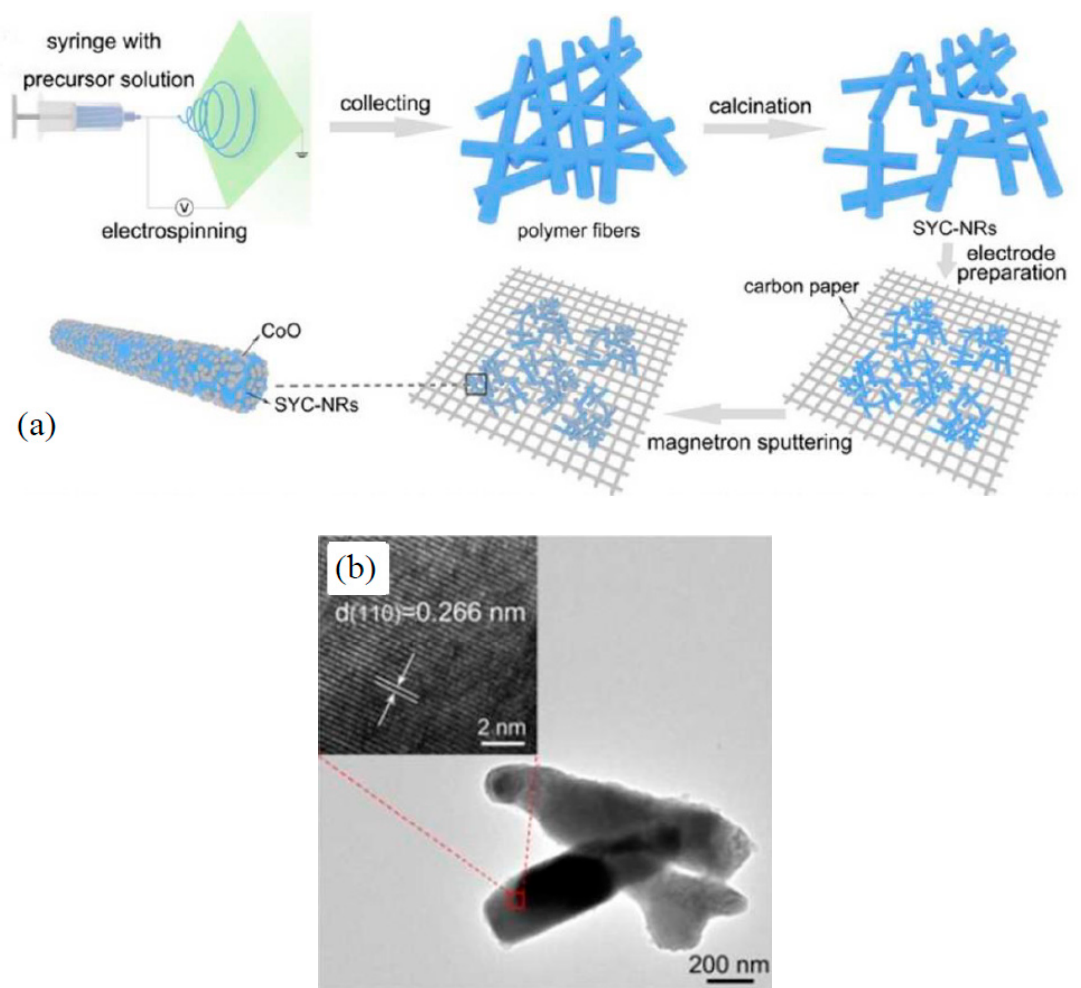
Figure 3. (a) Schematic illustration of strontium ytterbium cobalt-nanorods (SYC–NRs) synthesis through electrospinning and the CoO-coated electrode preparation process (b) TEM image of the synthesized SYC–NRs. Reprinted with permission from [62]. Copyright (2018), American Chemical Society.